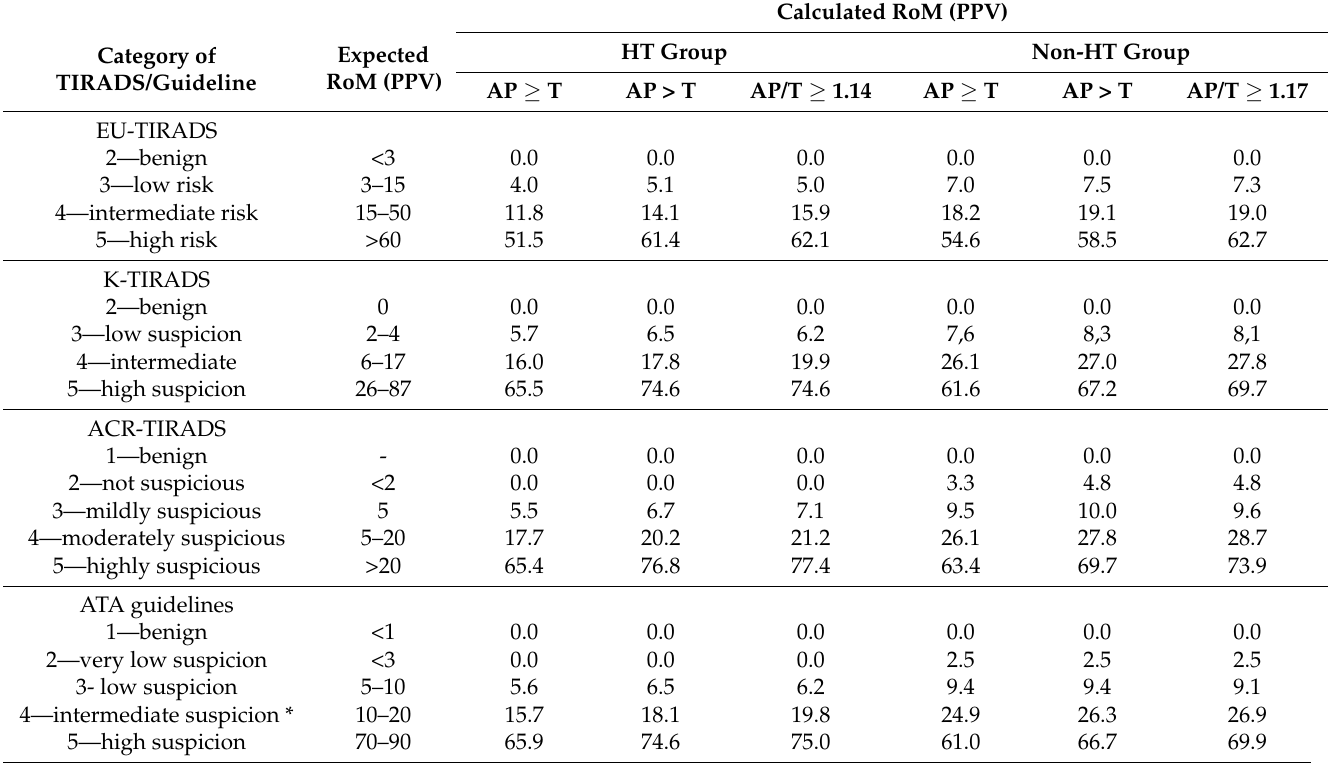
Table 3. Distribution of benign and malignant nodules between particular categories of TIRADS, the comparison of expected RoM with calculated RoM for each category (TIRADS categories corresponding to the lack of nodules have been omitted, nodule’s shape evaluated on the transverse plane).